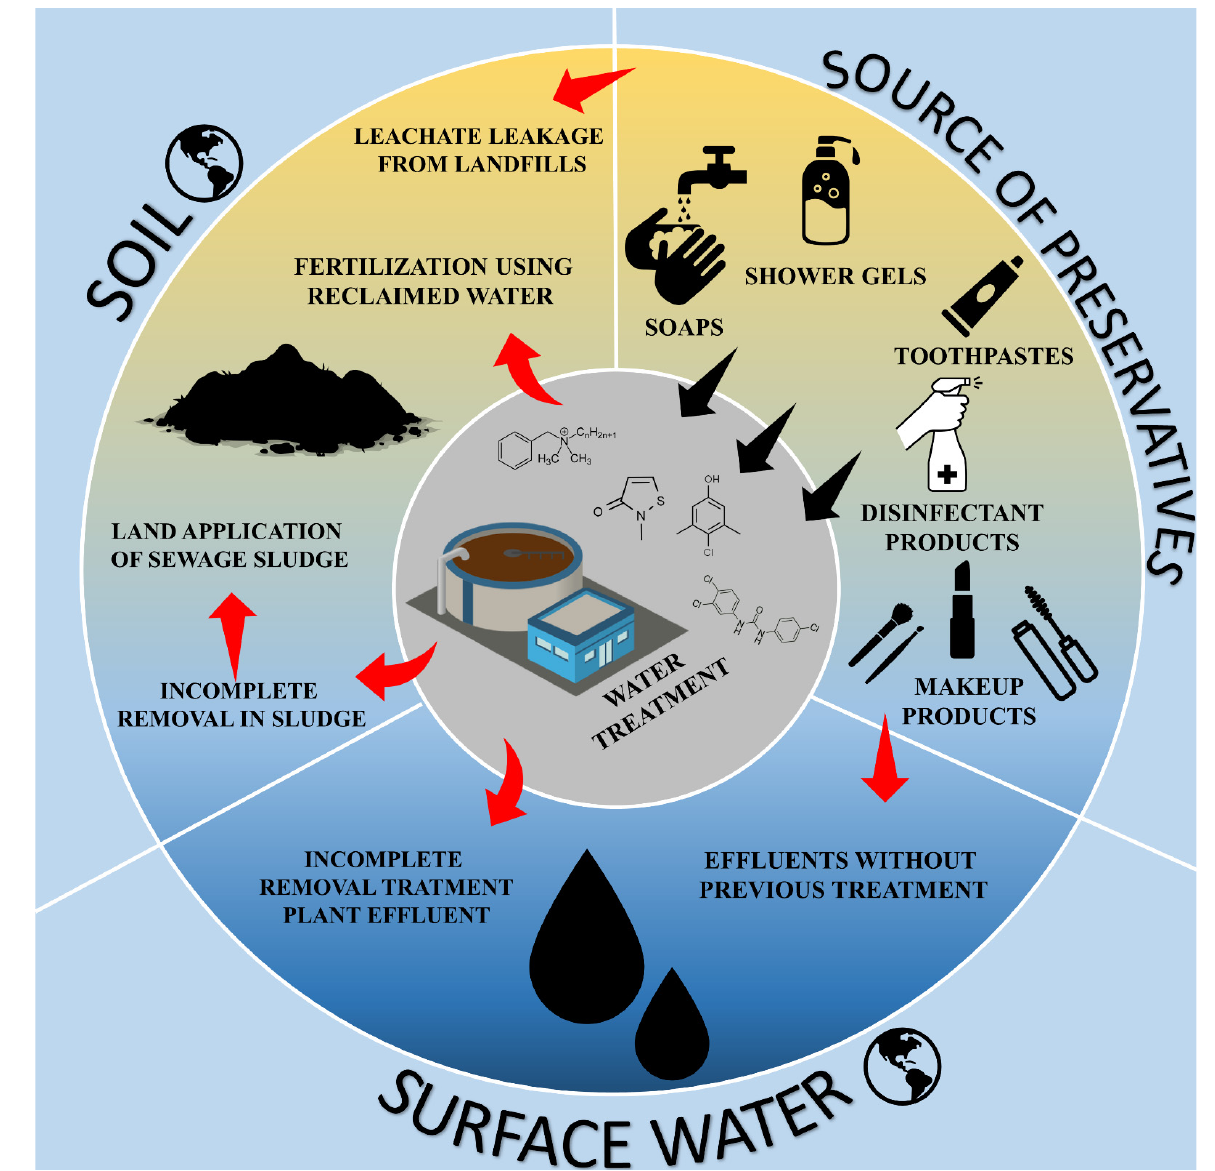
Figure 1. Environmental pathways for cosmetic preservatives.